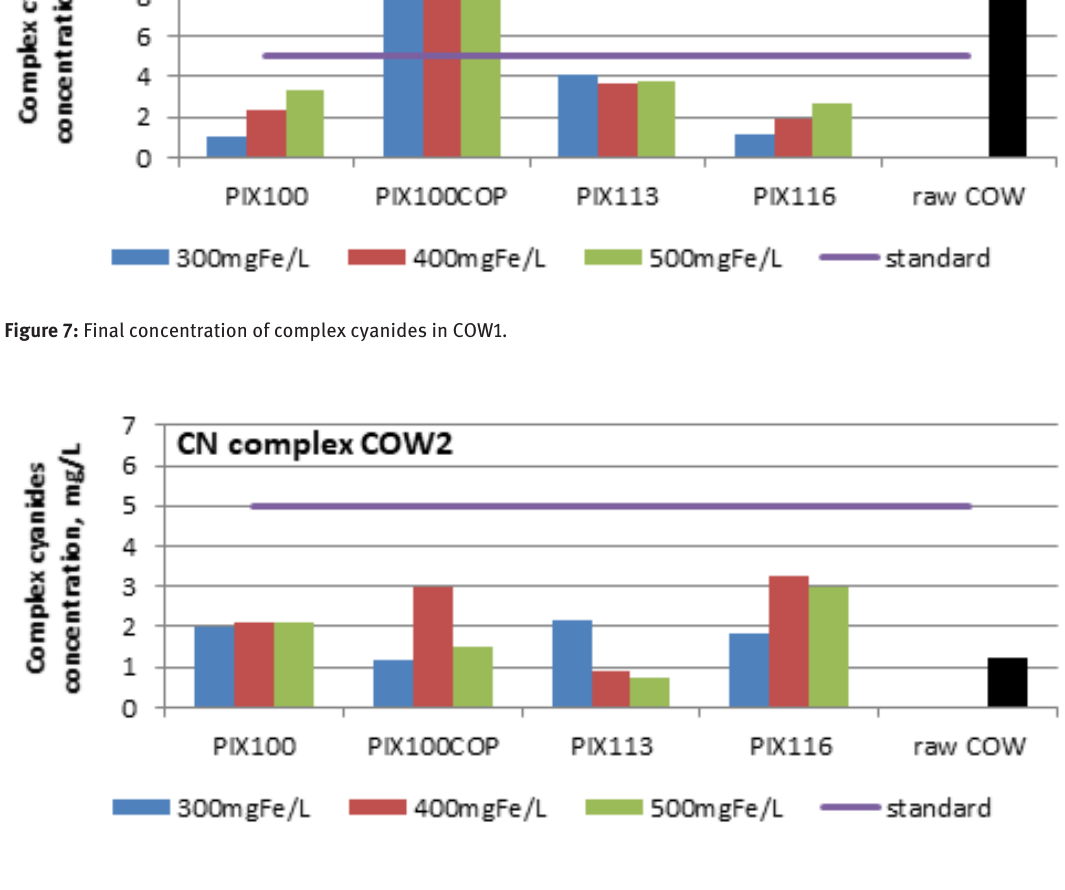
Figure 8: Final concentration of complex cyanides in